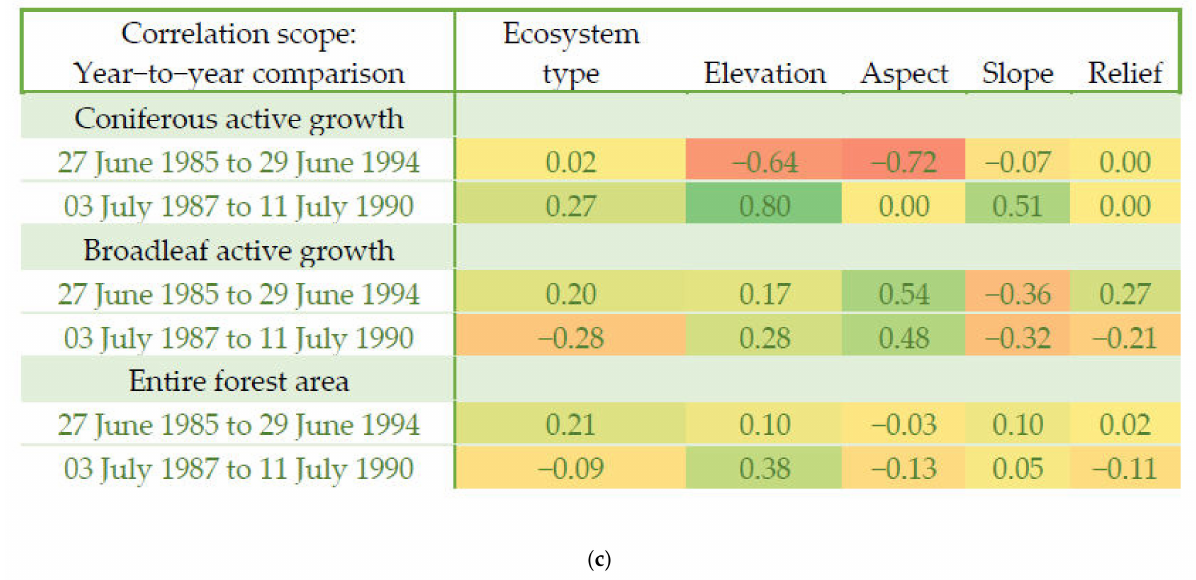
Figure 12. ( a ) Location of smaller scale focal areas with observed predominant coniferous and predominant broadleaf active growth within the study area; ( b ) Correlation coefficients between NDGI mean and other environmental factors within a vegetation season (note that correlations in the first scene are inverse since the 1977 scene is later in the vegetation season than the 1984 scene); ( c ) Correlation coefficients between NDGI mean and other environment factors as year-to-year comparison in the same part of the vegetation